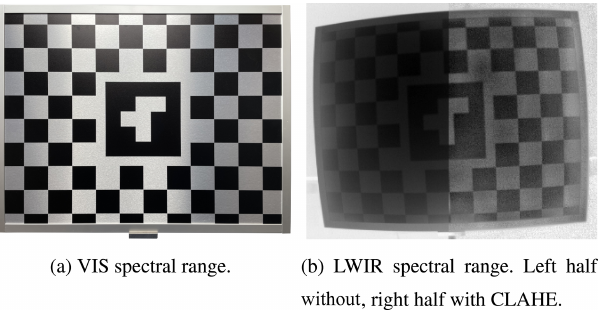
Figure 2. Examples of images of the proposed ArUco coded checkerboard